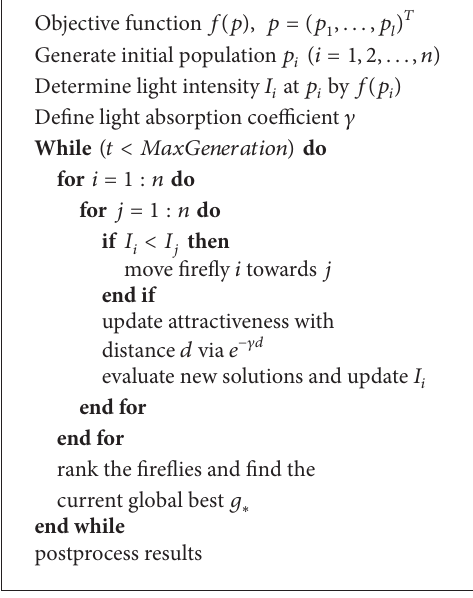
Algorithm 1: Firefly algorithm